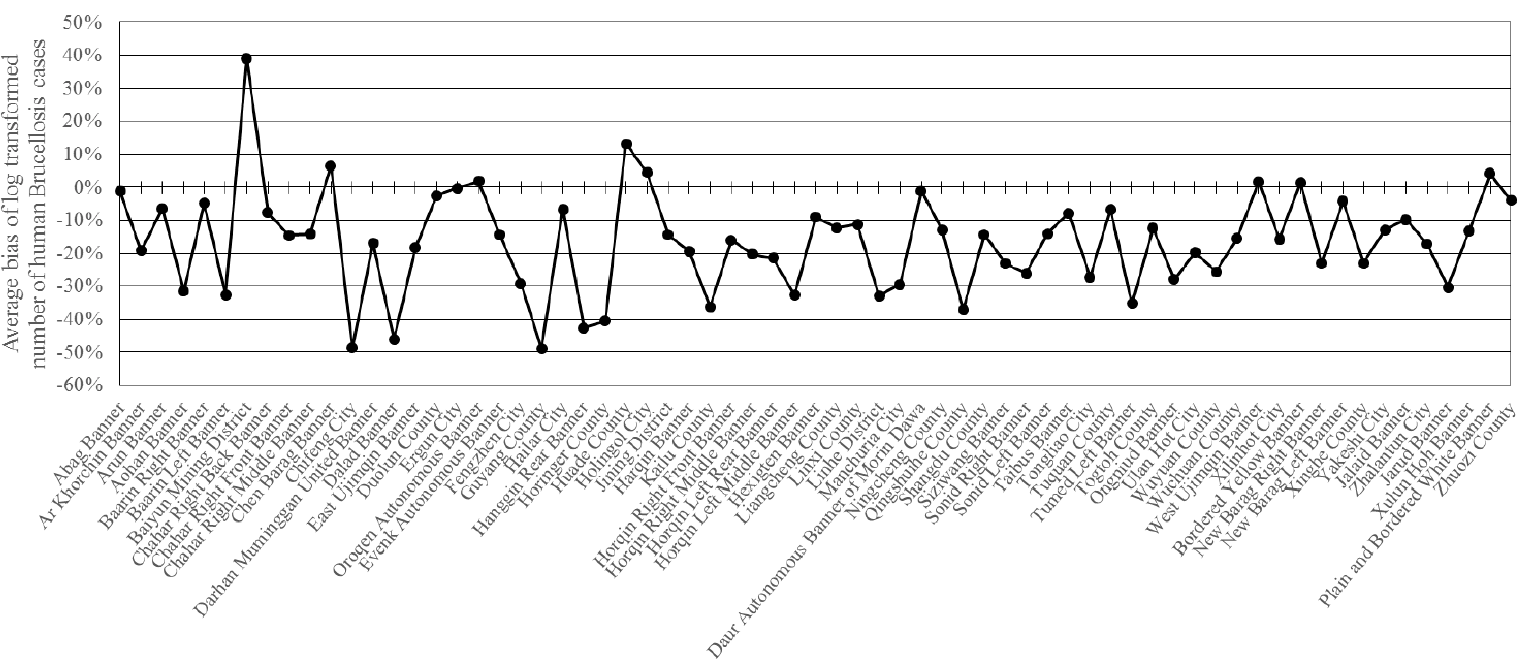
Figure 6. Percent errors of the log-transformed numbers of human brucellosis cases during 2009–2010 in 67 out of 89 counties in Inner Mongolia, China. The percent errors in the remaining 22 counties, outside of the − 50% to 50% error range, were described in the text, but left out in this figure for the sake of clarity.